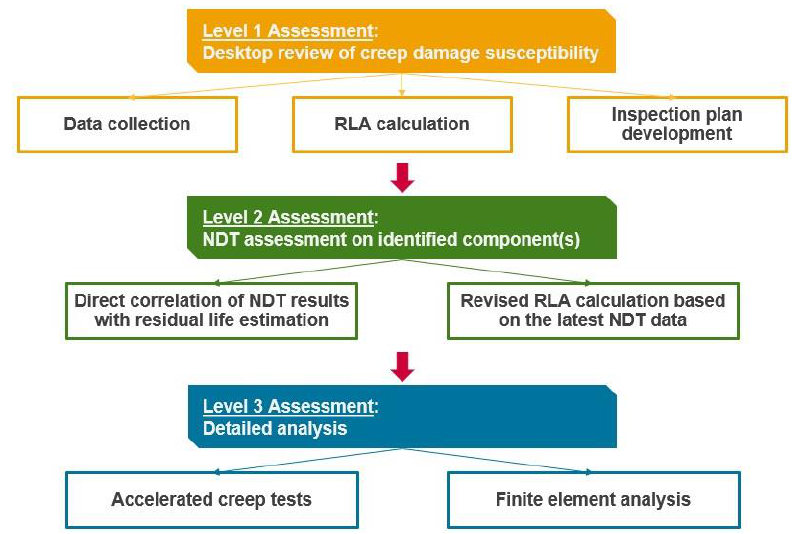
Figure 1. Proposed 3-level approach for creep